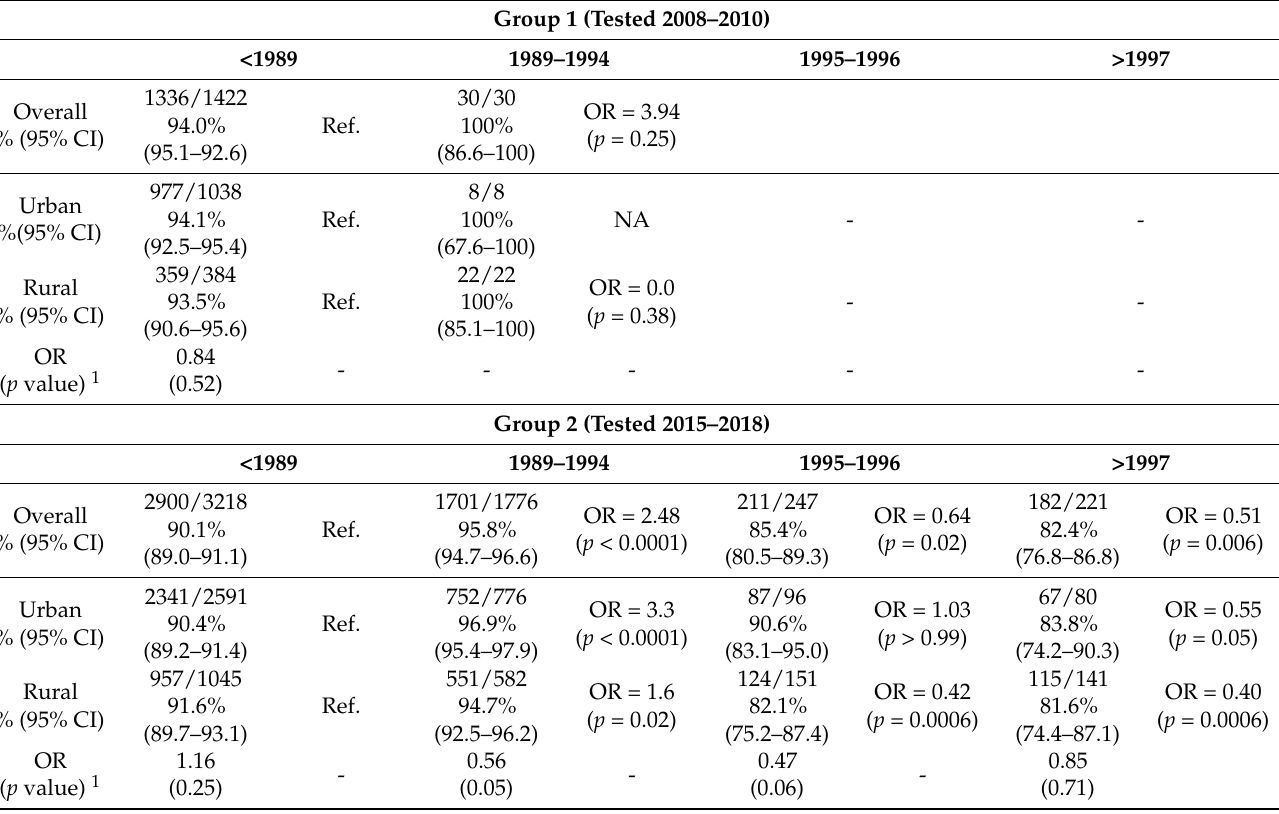
Table 1. Seroprevalence of rubella among fertile women according to the year of birth and place of residence.